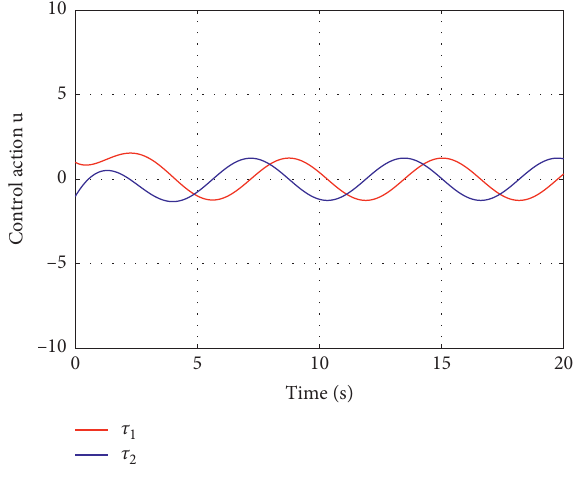
Figure 6: Control action